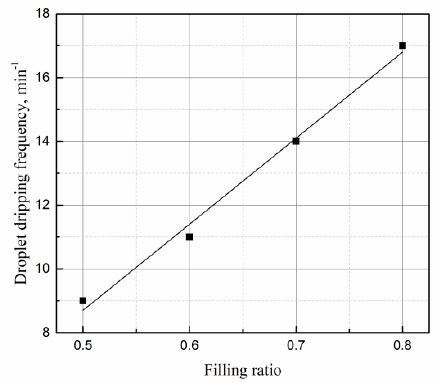
Figure 14. Relationship between droplet dropping frequency and filling rate in the physical